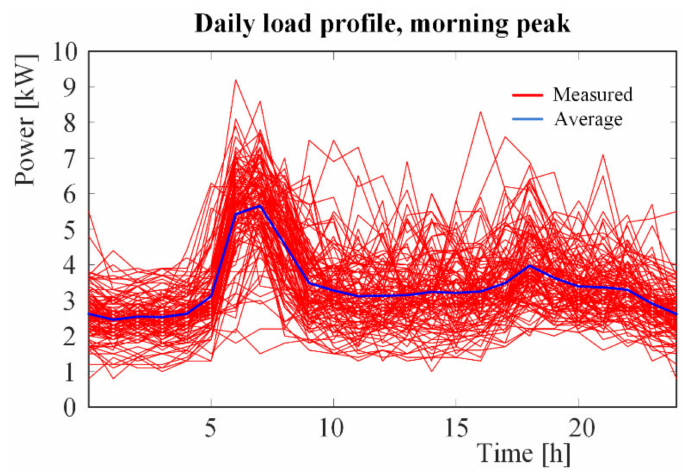
Figure 8. The morning peak consumption